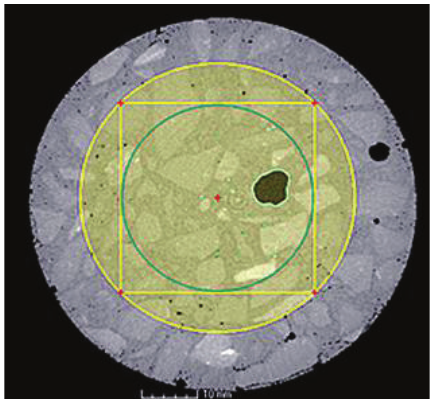
Figure 2: Sketch map of the partition of each specimen.